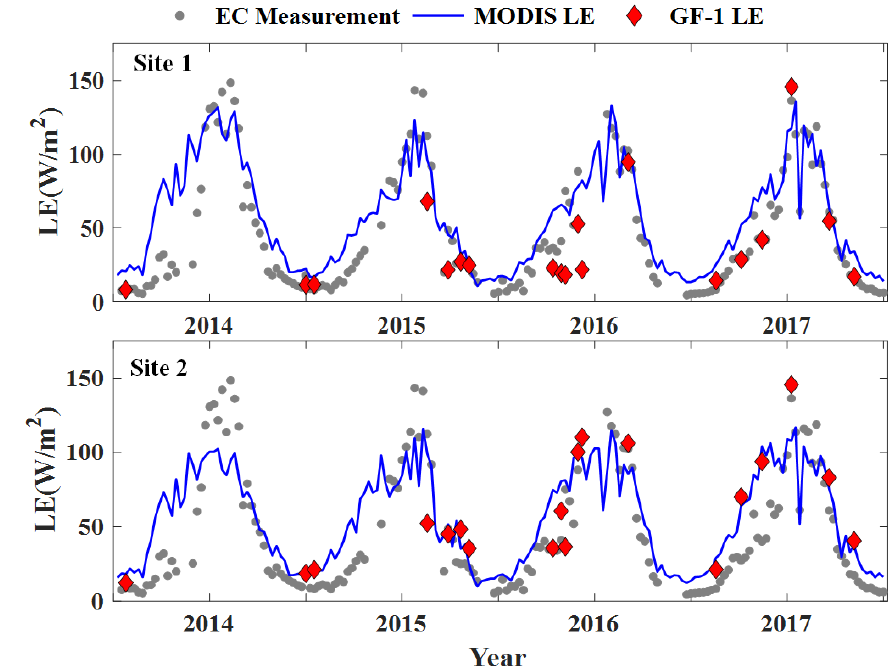
Figure 4. Intercomparison of 8-day averaged estimations and observations on time series of 2014–2017 for Site 1 (top panel) and Site 2 (bottom panel).